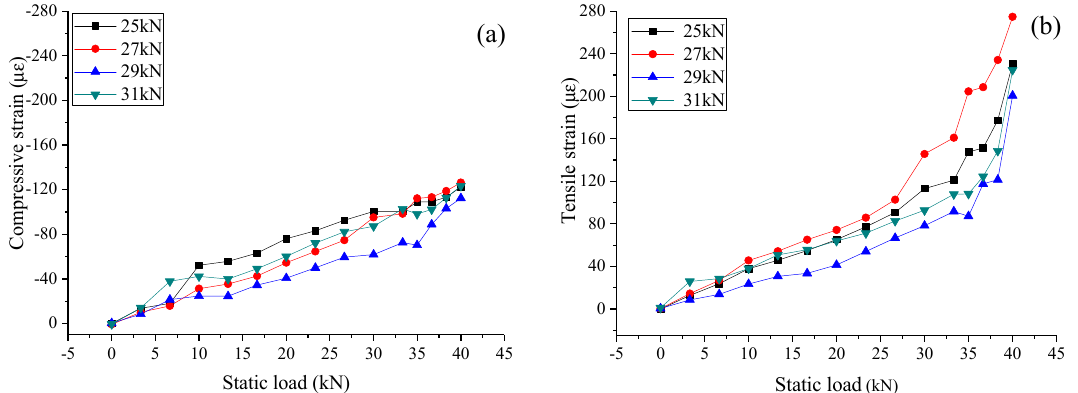
Figure 15. Structural dynamic response with different static loads: ( a ) compressive strain curves; ( b ) tensile strain curves.